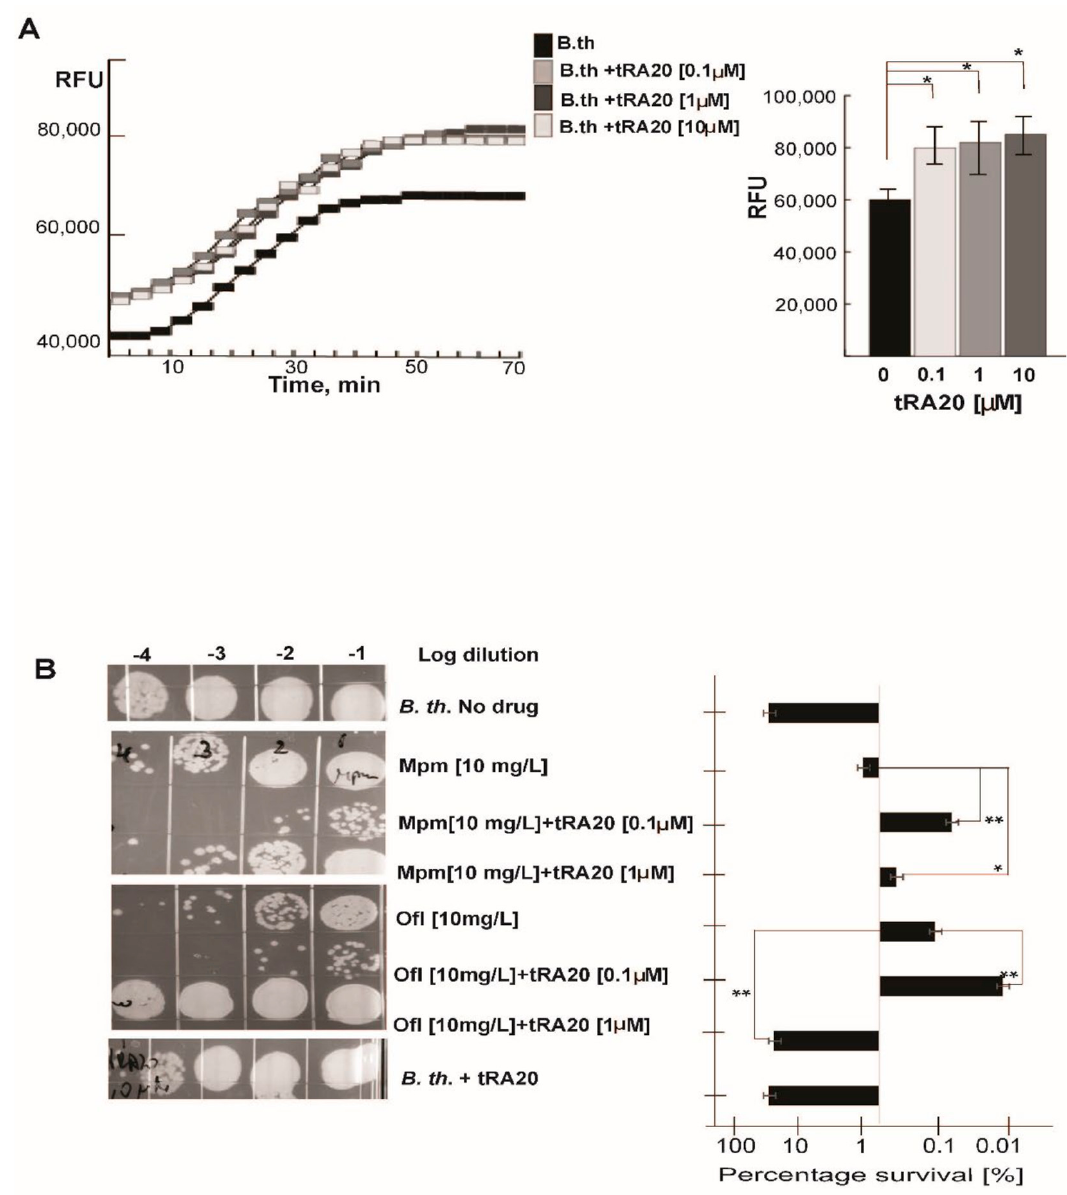
Figure 1. Reduction of B. thailandensis efflux capacity by a broad-spectrum inhibitor of mammalian ABC transporter systems affects the rate of bacterial persistence. ( A ) Accumulation of Hoechst 33342 (25 mM) was recorded as fluorescence intensity (RFU, relative fluorescence unites, Ex/Em 350/460) at 5 min after dye addition in untreated or pretreated with tRA99020 planktonic B.th. cultures. The kinetic of dye accumulation reflects 3 min recording intervals over a 60 min period. Data shown in bars represent the average and ± standard errors of the steady-state RFU means from four independent bacterial cultures. Paired Student’s t test was applied to calculate the significance (*, p < 0.01) of Hoechst 33342 accumulation in tRA99020-treated versus untreated bacterial cultures; ( B ) persistence was calculated as a percentage of surviving B.th . cells after 24 h of exposure to microbicidal concentrations of antibiotics relative to the bacterial cell number calculated prior to the addition of antibiotic. Bacterial counts at the early exponential growth curve (OD600 0.2) and after antibiotic treatment was determined as colony forming units at log10 serial dilutions. The tRA9902 compound was added at the indicated concentrations in combination with the antibiotics meropenem (Mpm) and ofloxacin (Ofl). The bar graph shows the average and ± standard errors of the means from six biological replicas. The statistical significance (*, p < 0.01 and ** p < 0.001) of tRA99020’s effect on antibiotic bactericidal efficiency was determined with a paired Student’s t test.